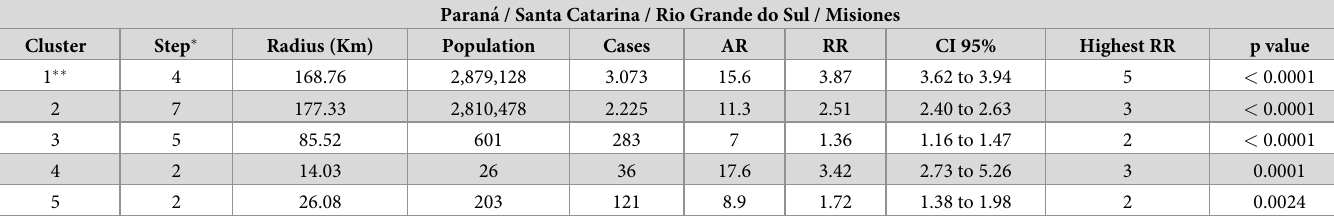
Table 3. Description of areas of relative risk for new cases of leprosy in Southern Brazil and Misiones, Argentina, 2010 to 2016.